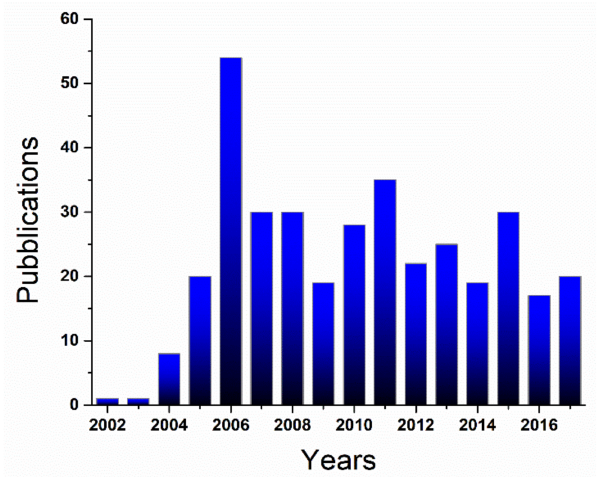
Figure 1. Number of publications on amides/imides compounds in the hydrogen storage field. Scopus sources.